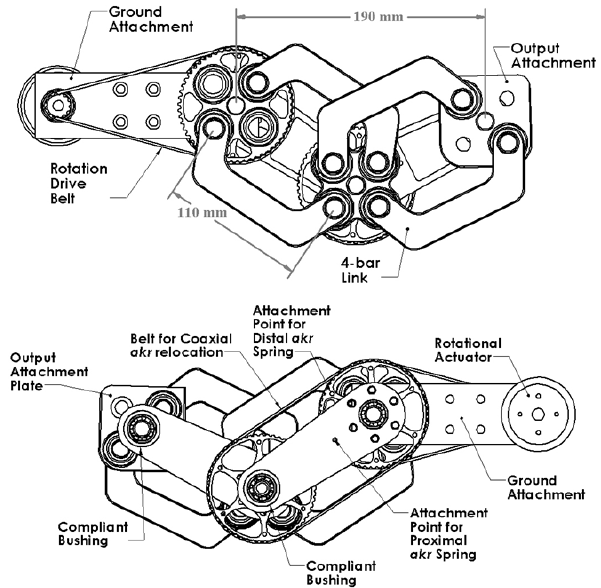
Figure 6. Technical Illustration for the mechanism as constructed. Illustrated from both sides. Top illustrates primarily the 4-bar com- ponent of the mechanism, while bottom illustrates the akr mecha- nism. This iteration will accommodate up to 10cm of misalignment, without restriction of motion. Mechanism as designed to compen- sate up to 100kg of applied load. Many structural members are sig- nificantly oversize to simplify manufacture and construction. All ro- tational joints for 4-bar linkages are supported by cylindrical roller bearings (SKF Bearing) rated to 13kN dynamic loading. Rotational joints for akr mechanism are supported by standard ball bearings (SKF Bearing). Teflon impregnated delrin is used as the material for the compliant bushing, due to its relatively high strength and desirable deformation characteristics. Synchronous belts are Gates GT